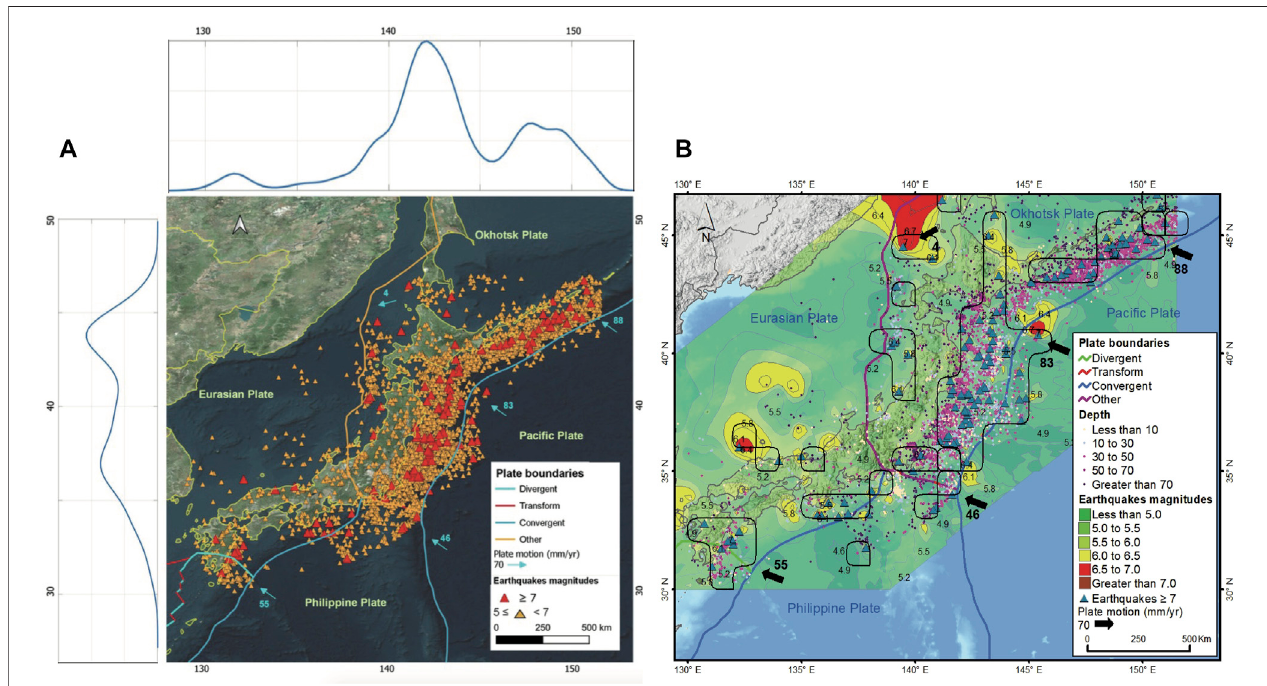
FIGURE 12 | Earthquake zones in Japan. (A) Seismic activity between 1900 and 2021 is shown as yellow triangles for 5 ≤ earthquakes magnitudes < 7, for 7 ≤ earthquakes magnitudes are marked withred triangles.Plate motion vectors (rotated based onthe direction ofplate movement), plate limits and earthquakesdata were taken from the USGS. The PDF (probability density distribution) of the longitude and latitude shows that the seismic zone has a trimodal and bimodal distribution, respectively. (B) DistributionofseismichazardsinJapan.Thespatialprobabilityofoccurrencefor5 ≤ earthquakesmagnitudes < 6isshowninshadesofgreen;for 6 ≤ earthquakes magnitudes < 7 is shown in shades of orange; and for earthquakes magnitudes ≥ 7 is shown in shades of red.